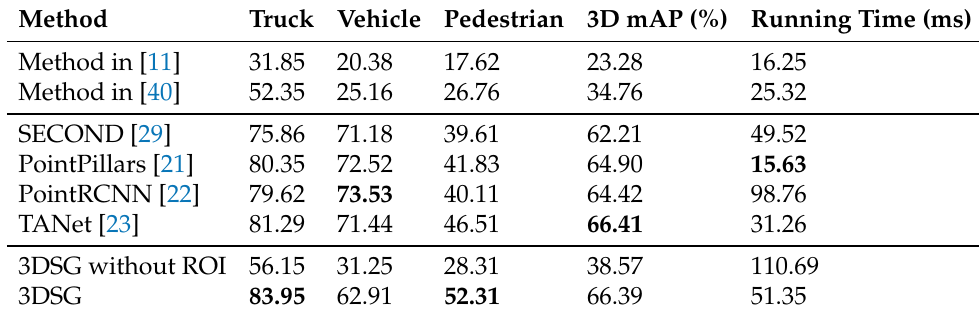
Table 2. Configuration parameters for the